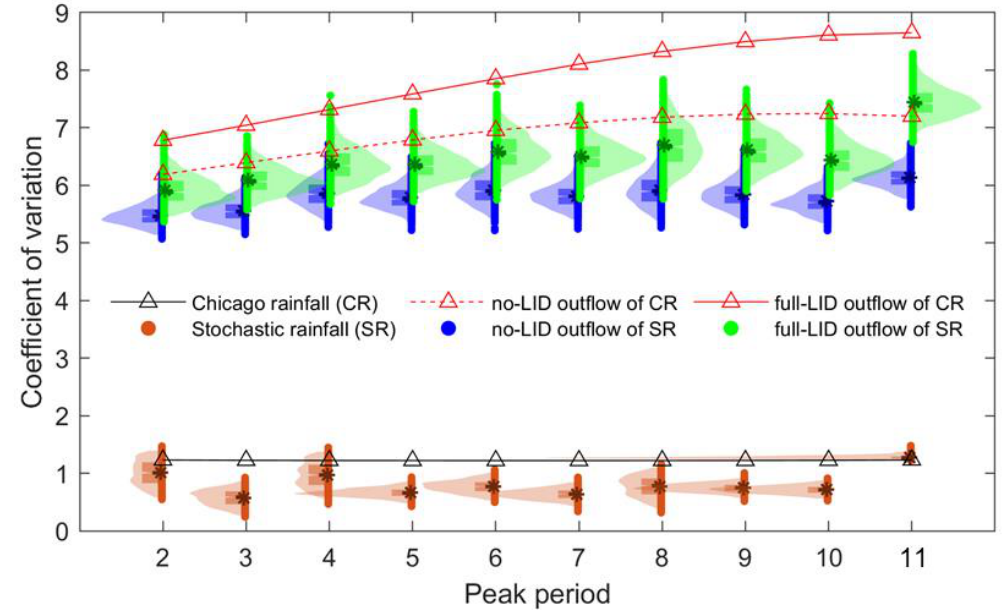
Figure 5. Variation coefficients of Chicago and stochastic rainfall time series and variation coefficients of corresponding outflow time series in no- and full-LID scenarios. * represents the median.